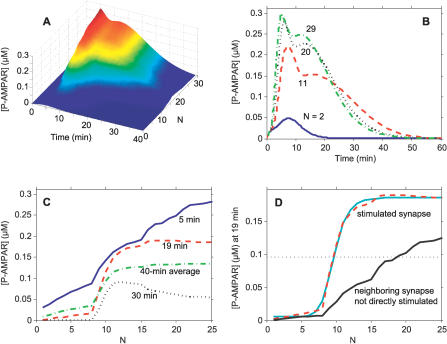
Concentration of Phosphorylated AMPARs at Various Time Points and at Various Numbers of Stimulated Synapses(A) [P-AMPAR] is three-dimensionally plotted against time and N.(B) [P-AMPAR] plotted against time at N = 2 (blue solid line), 11 (red dashed line), 20 (black dotted line), and 29 (green dash-dotted line).(C) [P-AMPAR] plotted against N at time = 5 min (blue solid line), 19 min (red dashed line), and 30 min (black dotted line), and at the 40-min average (green dash-dotted line).(D) [P-AMPAR] measured at 19 min plotted against N in a stimulated synapse (the synapse of interest, red dashed line) or a neighboring unstimulated synapse (black solid line). [P-AMPAR] of the stimulated synapse is superimposed on a sigmoid curve (light blue solid line) at an SF of 9.9 and N50% of 9.7 (see Results). The thin dotted line indicates [P-AMPAR]50%,19min.